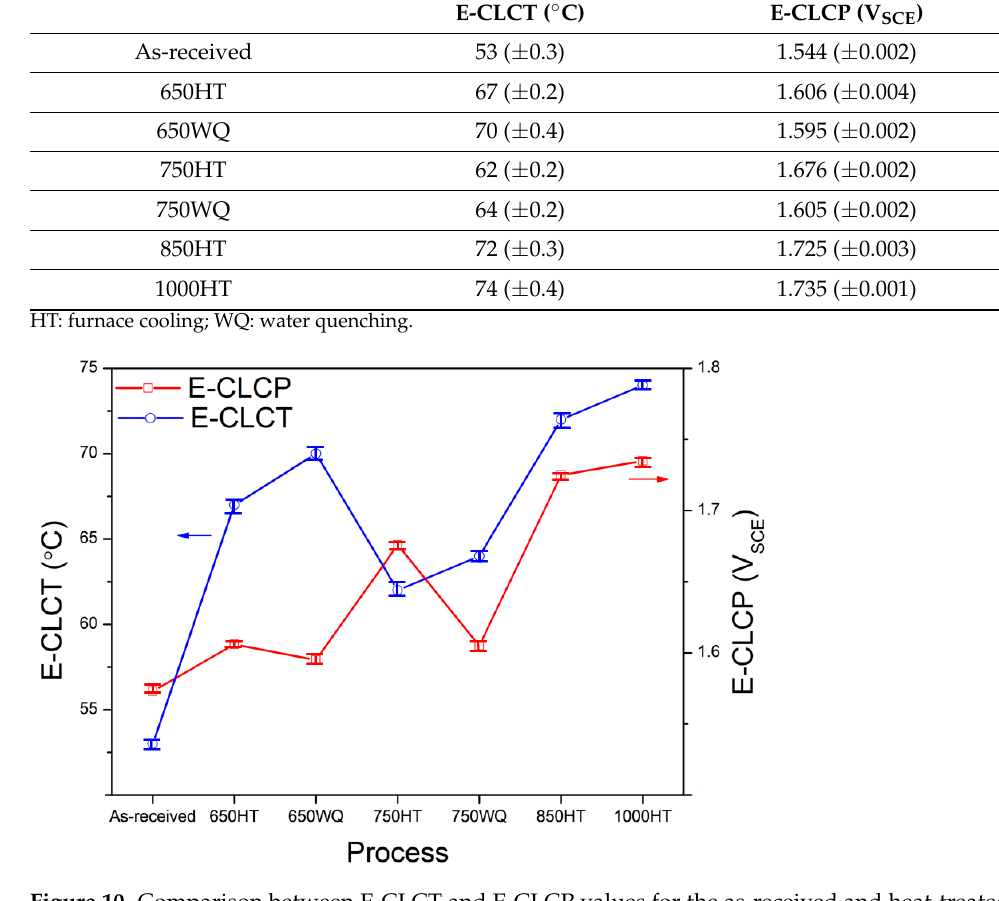
Figure 10. Comparison between E-CLCT and E-CLCP values for the as-received and heat-treated AM Ti–6Al–4V alloys (HT: furnace cooling; WQ: water quenching).